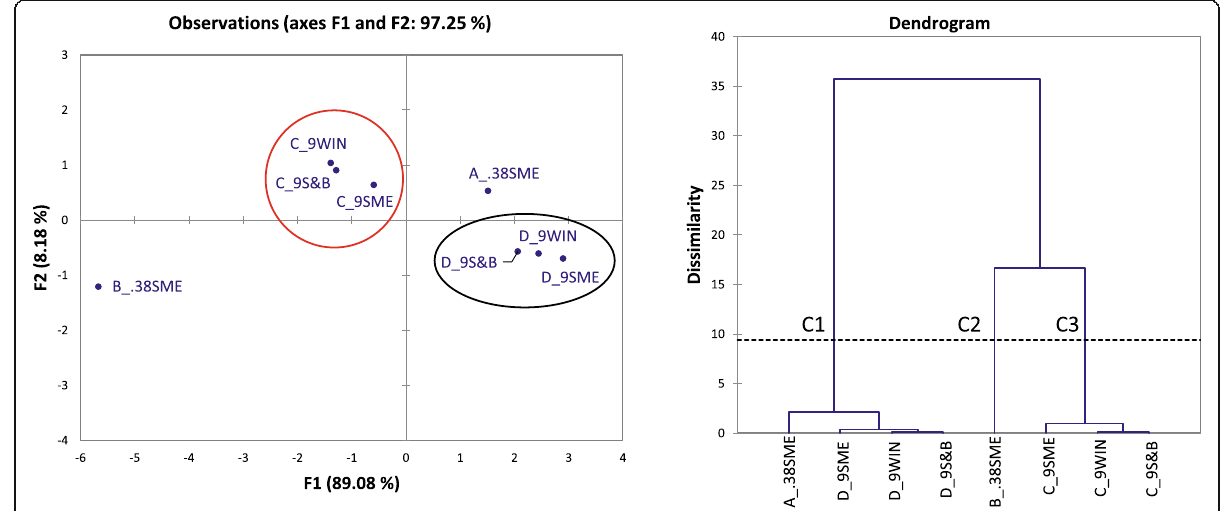
Fig. 6 PCA score plot of shooting test using different types of firearms (right). HCA dendrogram of firearms